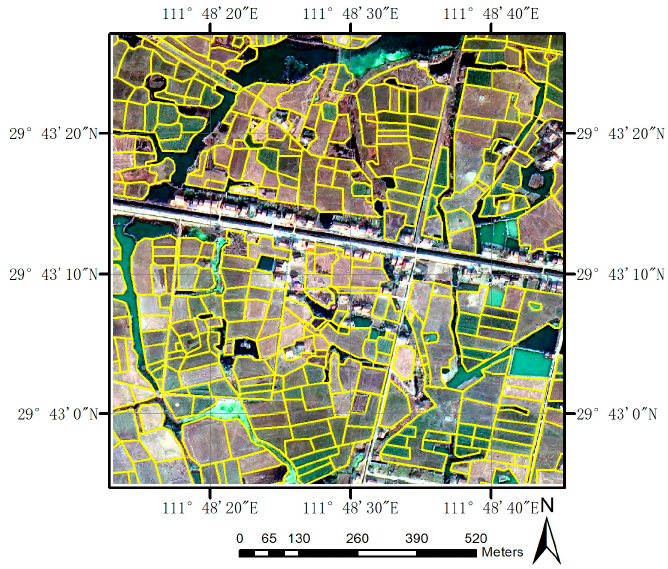
Figure 3. The precise boundaries of agricultural farming plots.